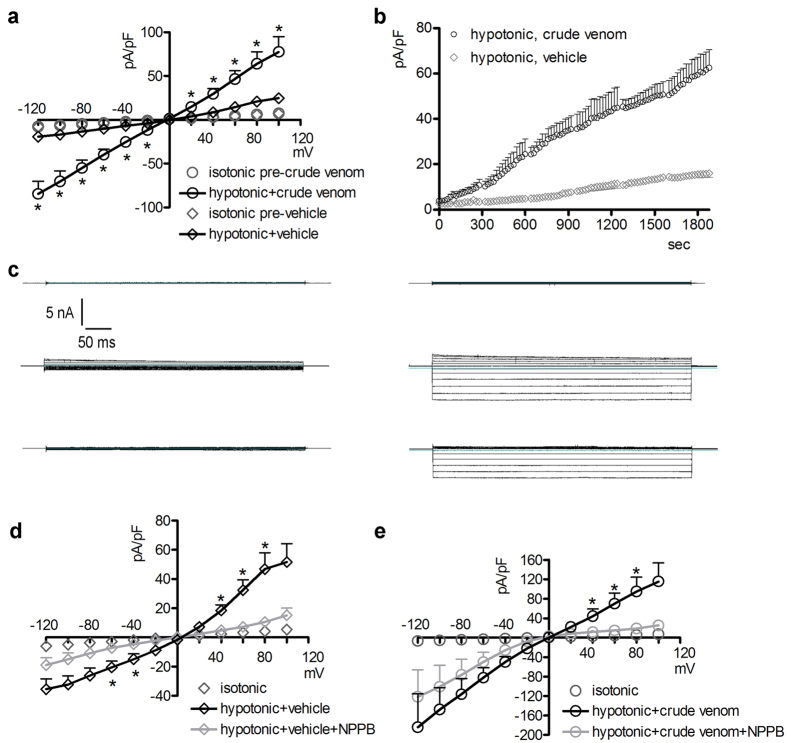
Crude venom greatly increases the magnitude of hypotonicity-stimulated ion currents.(a) Current density (pA/pF) to voltage (mV) and (b) current density (pA/pF) to time (sec) relationship of currents obtained from HEK 293 Phoenix cells in whole-cell configuration with pipette solution 1 (Table 2) and bath solutions 1 (isotonic, Table 1) and 2 (hypotonic, Table 1). The hypotonic solution contained either the vehicle (n = 42) or 0.025 μg/μl crude venom (n = 26). The current density-to-voltage relationship represented in (a) was measured before and after a 15 min hypotonic challenge. *p < 0.001 compared to hypotonic +vehicle, unpaired Student’s t test. In (b) p < 0.05 for all time points. (c) Original current recordings obtained with the above mentioned pipette and isotonic (top panels) and hypotonic bath solutions (middle panels) and after the addition of 60 μM NPPB to the hypotonic bath solution (lower panels) in vehicle (left) or venom-treated (right) cells. Current density-to-voltage relationship obtained with the abovementioned pipette, isotonic and hypotonic solutions (after a 30 min hypotonic challenge) containing either the vehicle (n = 6), (d) or crude venom (n = 6), (e) and after the addition of NPPB to the hypotonic solution. *p < 0.05 compared to hypotonic +NPPB, paired Student’s t test.